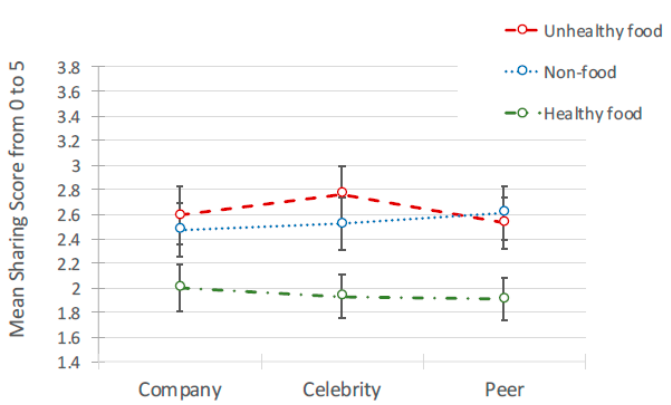
Figure 4. Likelihood to share: Mean scores.